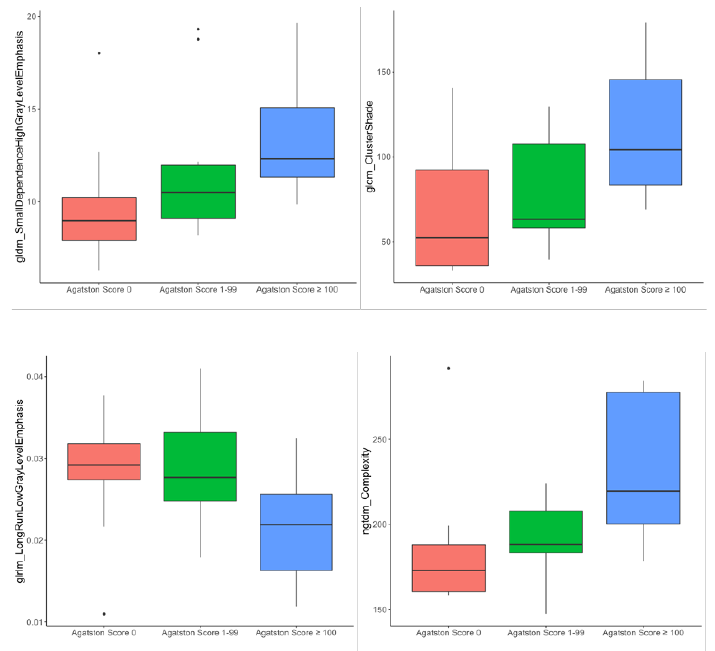
Figure 5. Distribution of “gldm SmallDependenceHighGrayLevelEmphasis”, “glcm ClusterShade”, “glrlm LongRunLowGrayLevelEmphasis”, and “ngtdm Complexity” feature within the